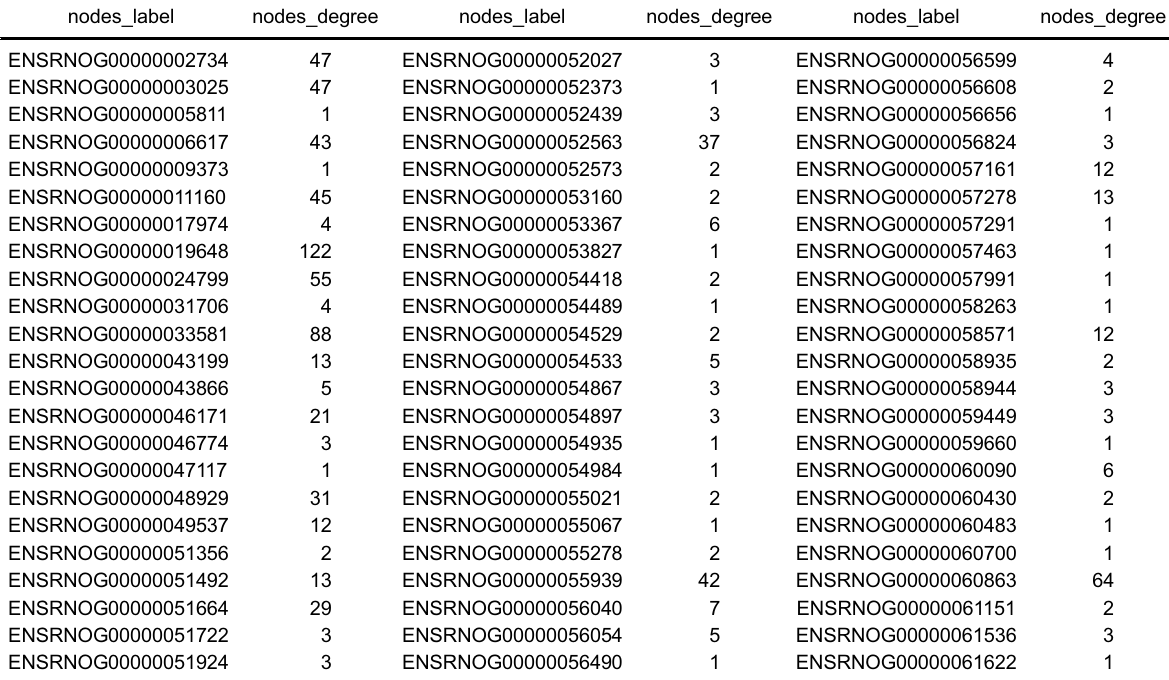
Table 5. Known long non-coding RNA genes and their node degrees in Cytoscape co-expression network.